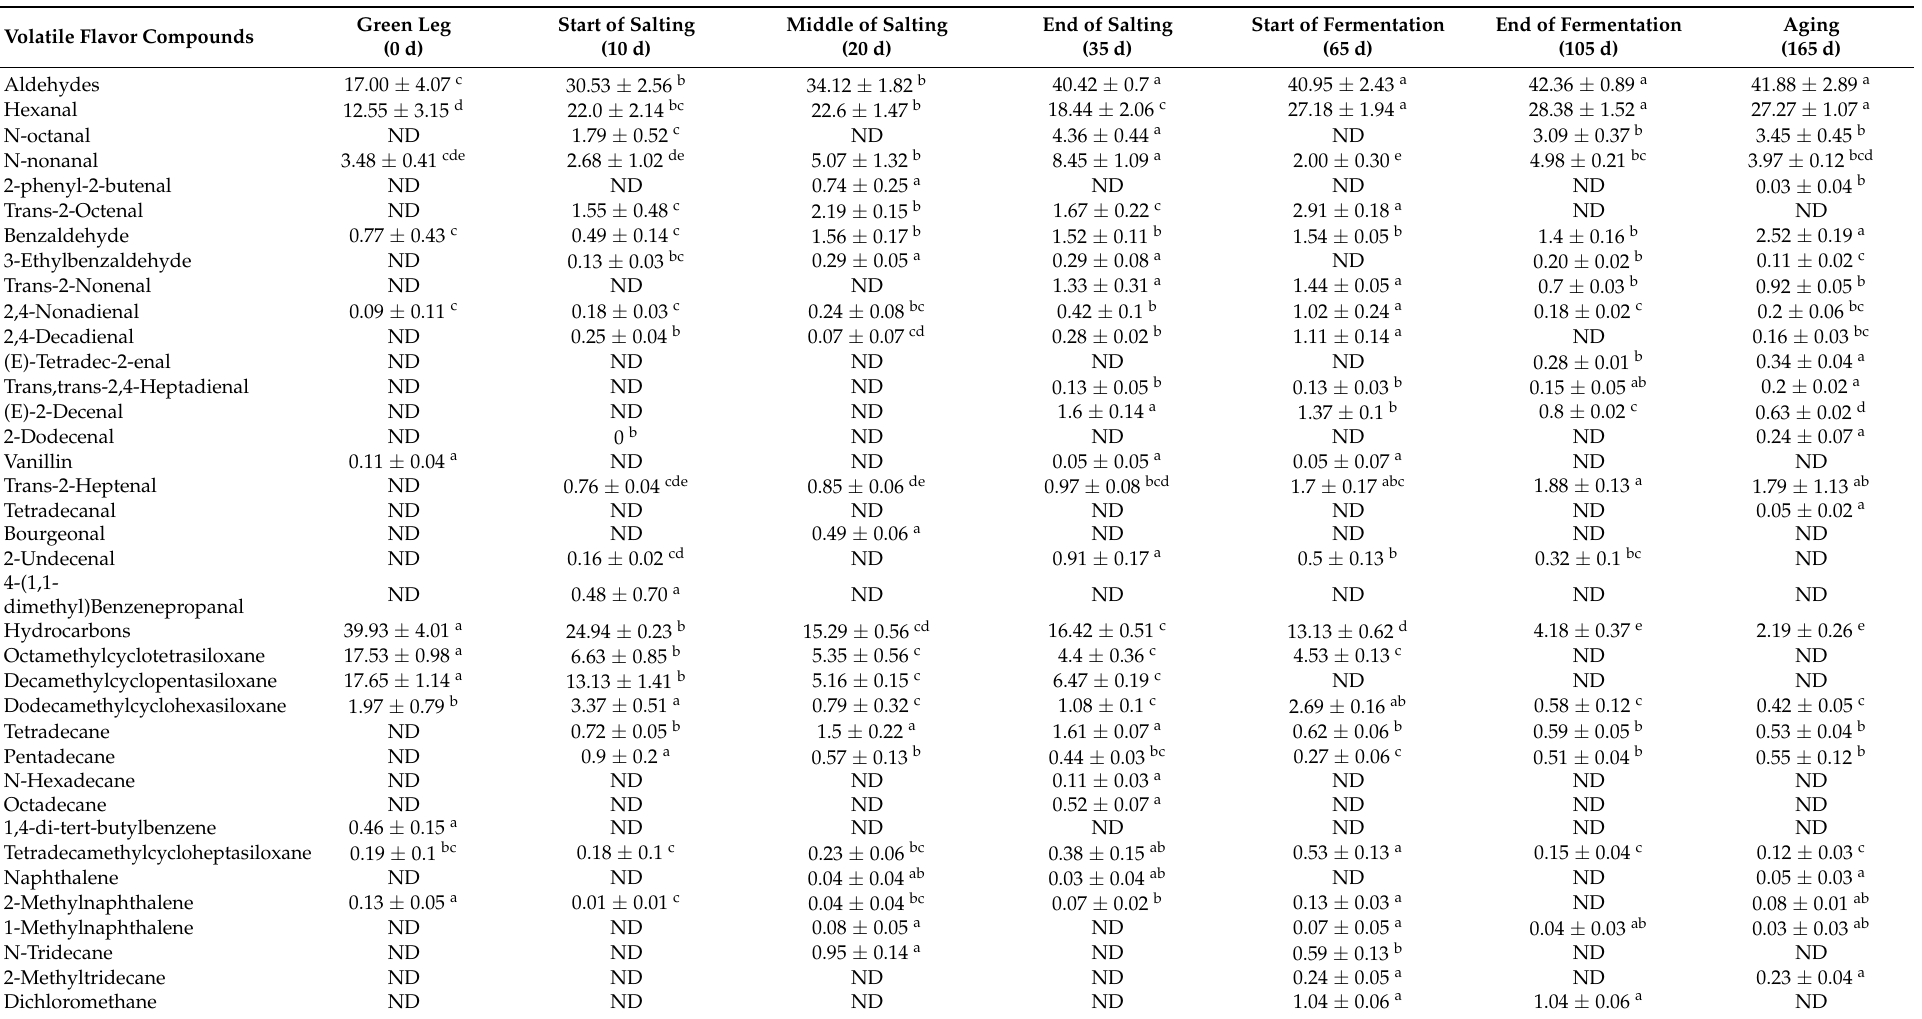
Table 4. Changes of volatile flavor compounds in samples during the processing of dry-cured donkey leg